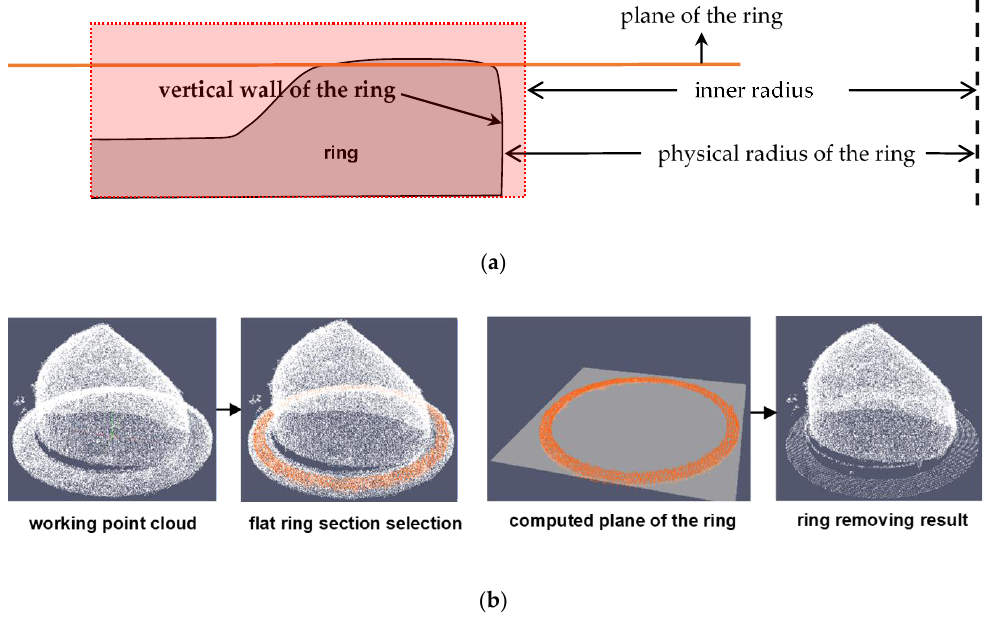
Figure A6. Ring removing procedure: ( a ) point removing criterion; ( b ) full ring removal procedure, as applied to the Test breast phantom B1.